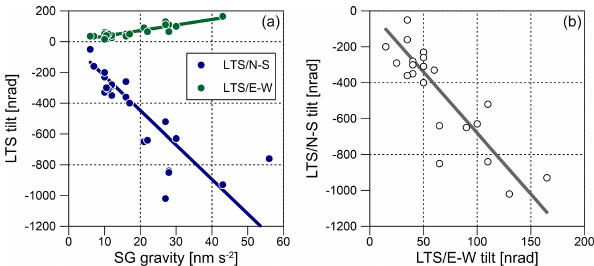
Figure 10. Long-term tilt (LTS) and gravity residuals (water perco- lation phase). Relation between the amplitudes of long-term tilt and gravity residual anomalies (a) . Relation between the amplitudes of long-term N–S and E–W tilt residual anomalies (b) . The average ratio of N–S to E–W tilt is − 0 .